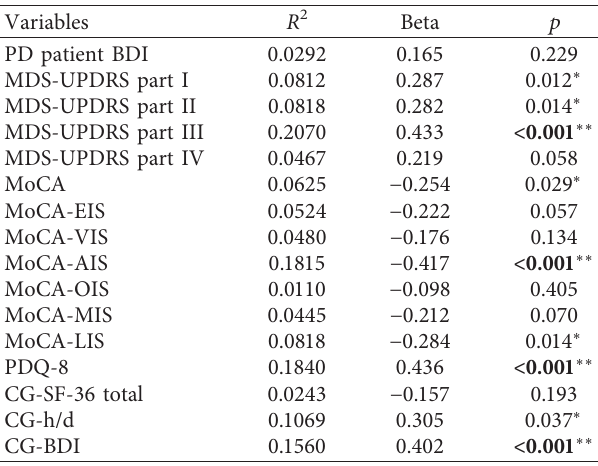
Table 3: Linear regression analysis of factors influencing patient health-related quality of life (PDQ-8), n �